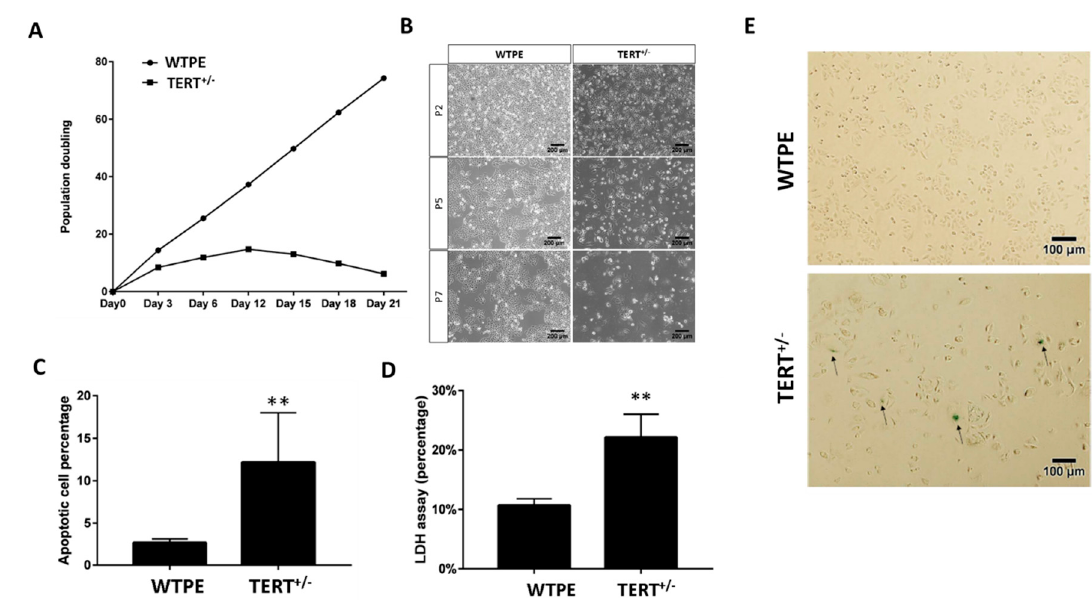
Figure 3. Retarded growth and increased cell death in Tert +/ − cancer cells. ( A ) Population doubling time of WT and TERT +/ − Hela cells. ( B ) Light microscopy images of WT and TERT +/ − Hela cells at Passage 2 (P2), P5 and P7. ( C ) β -gal staining of WT and TERT +/ − Hela cells. Arrows: example of severely senescent cells. ( D ) Cell death rates of WT and TERT +/ − Hela cells determined by LDH assay. ( E ) Quantification of flow cytometry analysis of annexin-V and propidium iodide (PI) staining of apoptotic cells in WT and TERT +/ − Hela cells. ** p < 0.01.